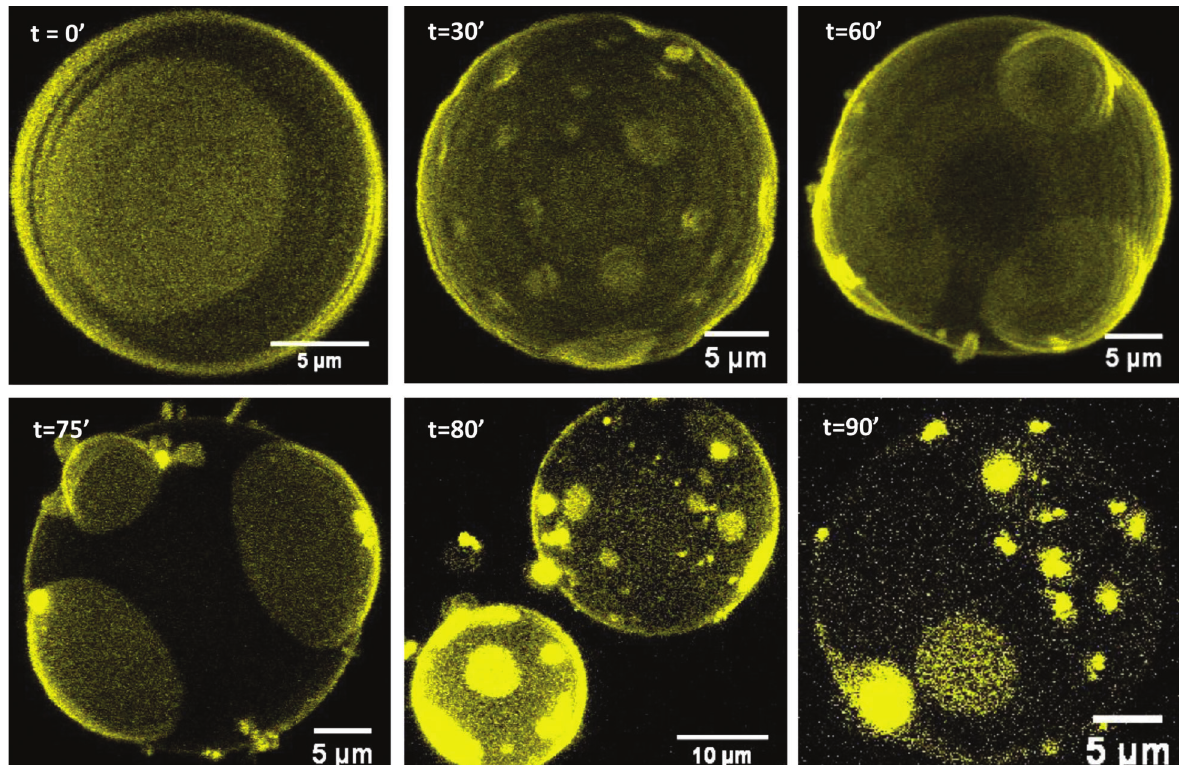
Figure 3. 3D projection at Z-plan of giant unilamellar vesicles formed of DOPC/DPPC/cholesterol (23:47:30 molar ratio), labelled with 0.5 mol% of DiIC 18 , obtained by fl uorescence confocal microscopy. The images were acquired at different times after addition of artepillin C and analyzed up to 90 min, at